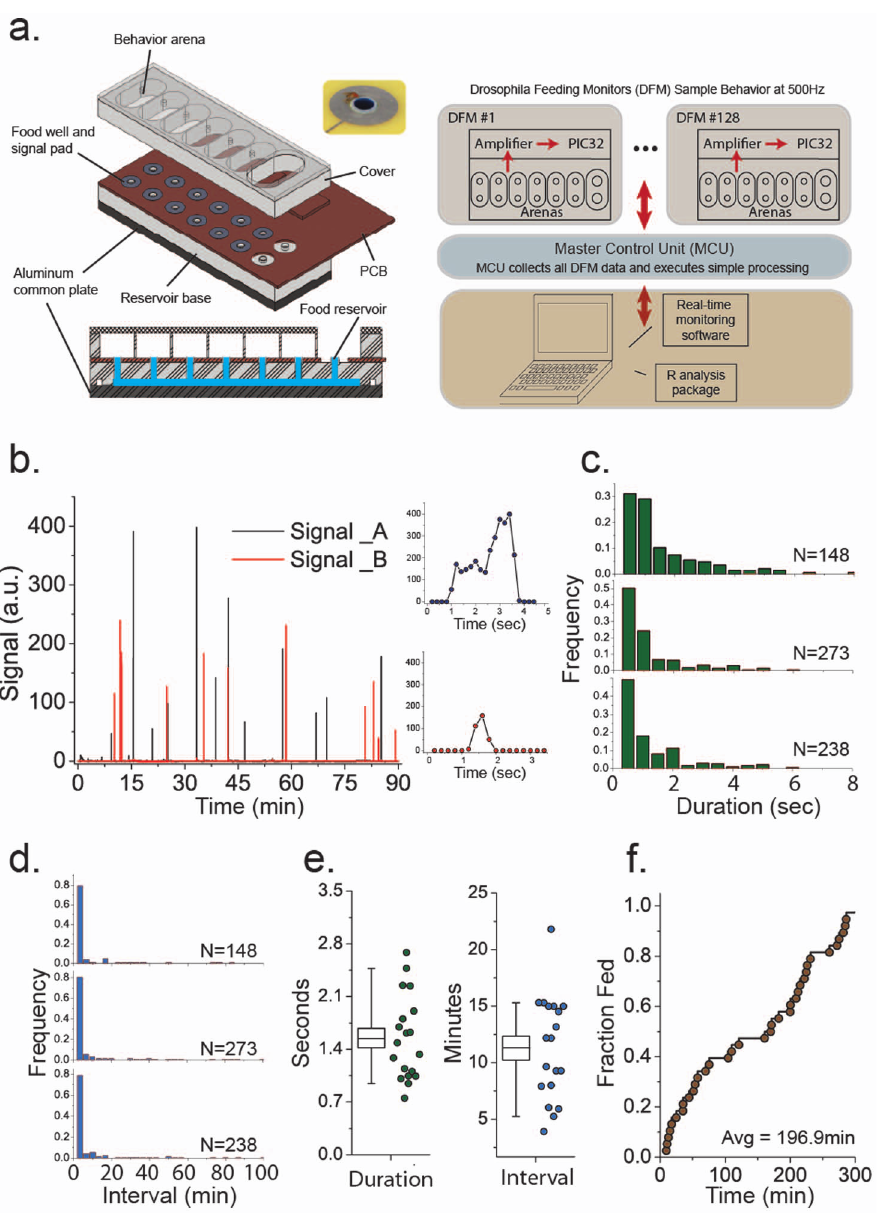
Figure 1. Illustration of the FLIC system. (A) Cartoon of the Drosophila Feeding Monitor (DFM) from the top- and side-view along with a flowchart of data collection and processing. Analog signals from all DFMs are collected by the Master Control Unit (MCU), which relays the information to the PC where the signals are visualized and recorded by the real-time monitoring software. (B) Representative signals from each of two feeding wells within a single feeding arena taken from a 90 min subset of a 24-hour feeding measurement. Close-up signal patterns representative of two distinct classes of feeding behavior events are presented as insets. (C) Histograms representing the distribution of durations for individual feeding behavior events (an event is a set of contiguous signals above baseline) over a 24 hr measurement period. Each plot represents values from a single fly, and distributions for three flies are presented. N represents the number of behavior events observed. (D) Histograms representing the size of the intervals between successive feeding behaviors over a 24 hr measurement period. Each plot represents values from a single fly, and distributions for the same three flies as in panel C are presented. (E) Among-fly variability in the average feeding duration and average time between feeding events. Each point represents the average value over a 24 hr period (N=21). (F) Event-time distribution that represents the fraction of the population that has experienced at least one feeding at a given elapsed time from a randomized point between 12pm-2pm (N=21). It took roughly 197 min for 50% of the population to feed at least once during this time of the